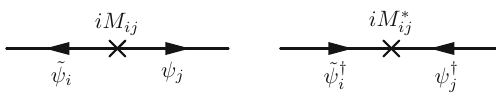
Fig. 6 Messenger clashing vertices from explicit mass terms